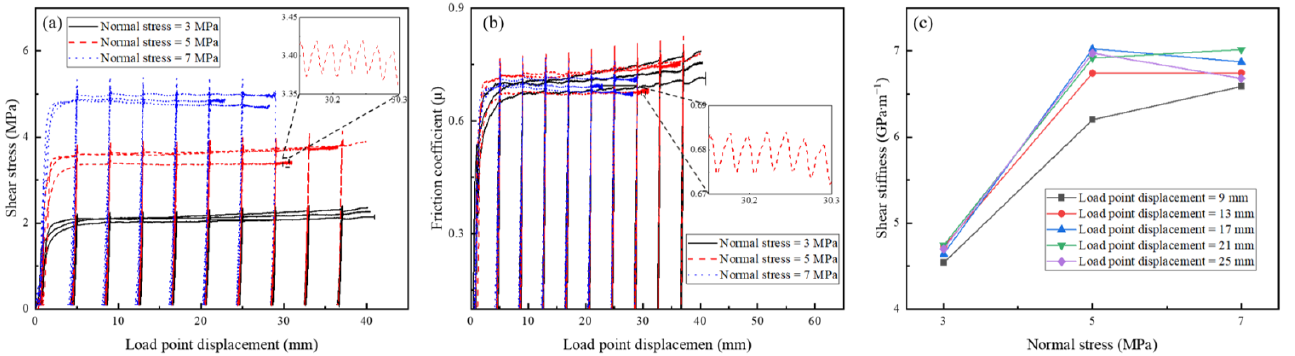
Figure 6. Test results with different normal stress. ( a ) Trend of shear stress on faults with slip displacement. ( b ) Trend of friction coefficient on faults with slip displacement. ( c ) Trend of the average shear stiffness on faults with normal stress.